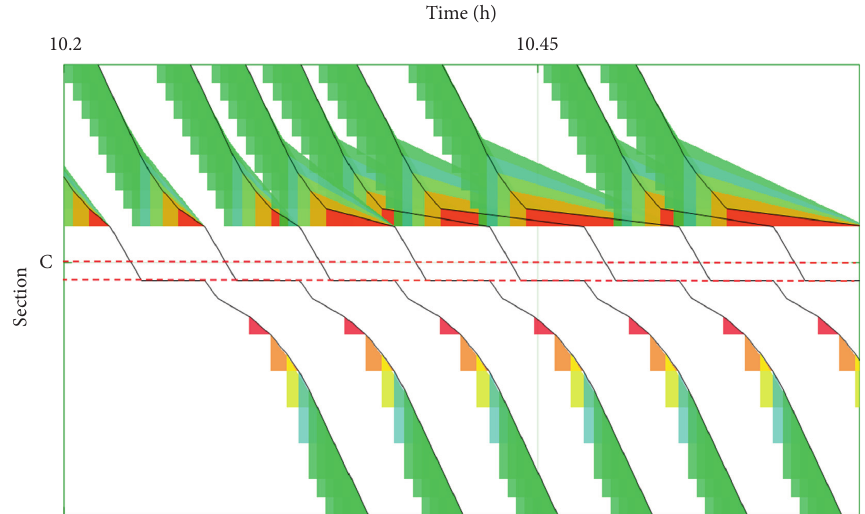
Figure 13: Timetable adjusted without siding line blockage in station